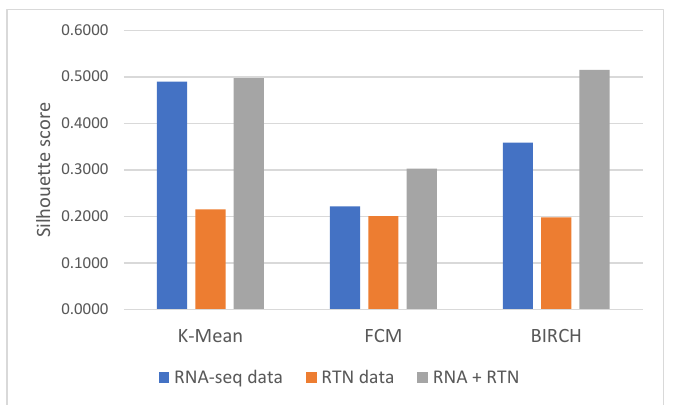
Figure 1. Silhouette Coefficient analysis of different features and clustering methods. Silhouette Coefficient scores were calculated for clusters generated with three methods (as denoted in the graph): K-means, FCM and BIRCH. Briefly, the Silhouette Coefficient reflects the ratio between the average geometric distance between patients in the different clusters to patients in the same cluster. Silhouette Coefficient values range from − 1 to 1, with a value of 1 reflecting perfect separation between